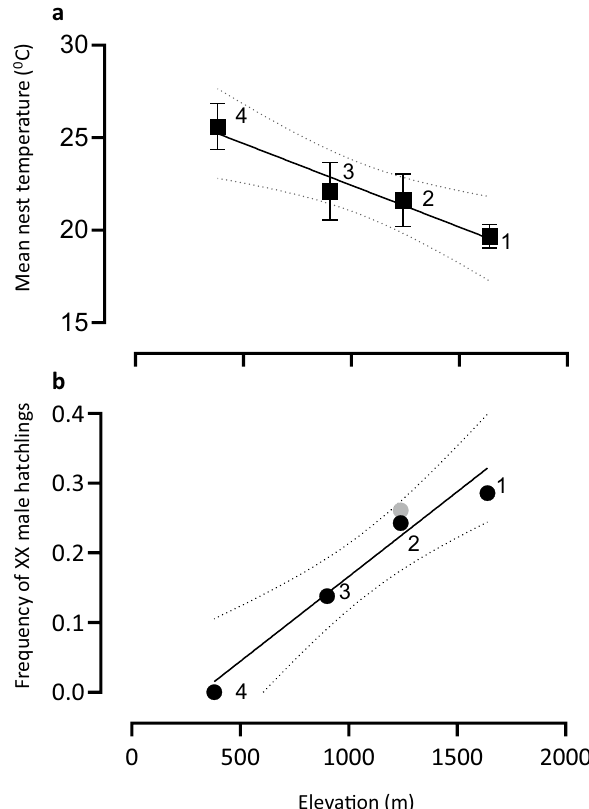
Figure 6. The frequency of sex reversal in nests Bassiana duperreyi . ( a ) Linear regression of mean nest temperature in each field location (F 1,2 = 41.71, P = 0.023; R 2 = 0.95). ( b ). The trend in sex reversal frequency of B. duperreyi with the elevation (F 1,3 = 41.71, P < 0.05; R 2 = 0.95). The number indicates field locations, as indicated in Fig. 1. Grey circles indicate first season data (2017/18) and black circles indicate second season data (2018/19). Broken lines denote the 95% confidence interval, and significance was assumed if P <